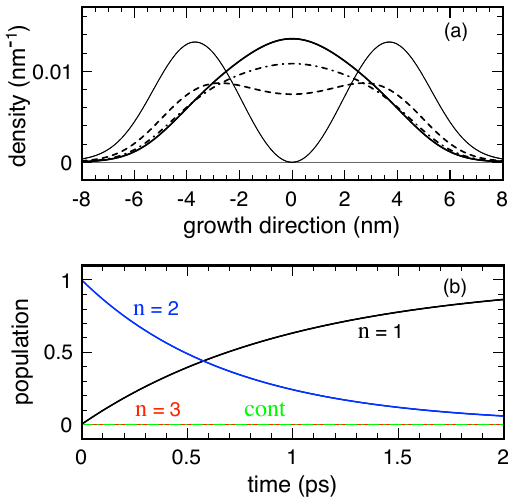
Figure 9. The same as in Figure 4 ( a ) and in Figure 5 ( b ) but for the proposed nonlocal RTA model in = 1ps and 1/ Γ diss = 0.7ps. Reprinted from [61]. Equation (32) with 1/ Γ diss 2 1